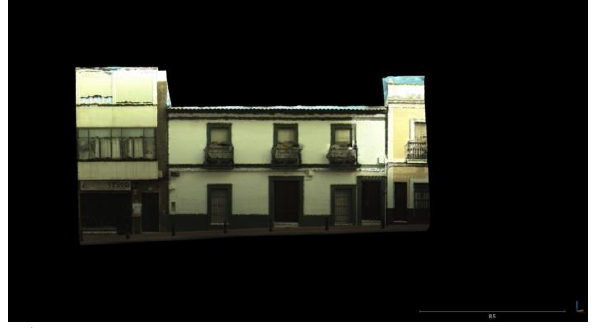
Figure 4. Comparison with LS. Distance map between both 3D models(Top) and photorealistic model with the proposed